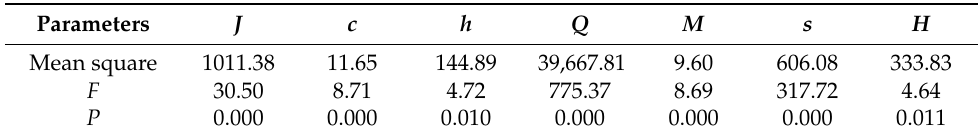
Table 2. ANOVA results of the influence of surround changes on the colour appearance properties of serpentinite.